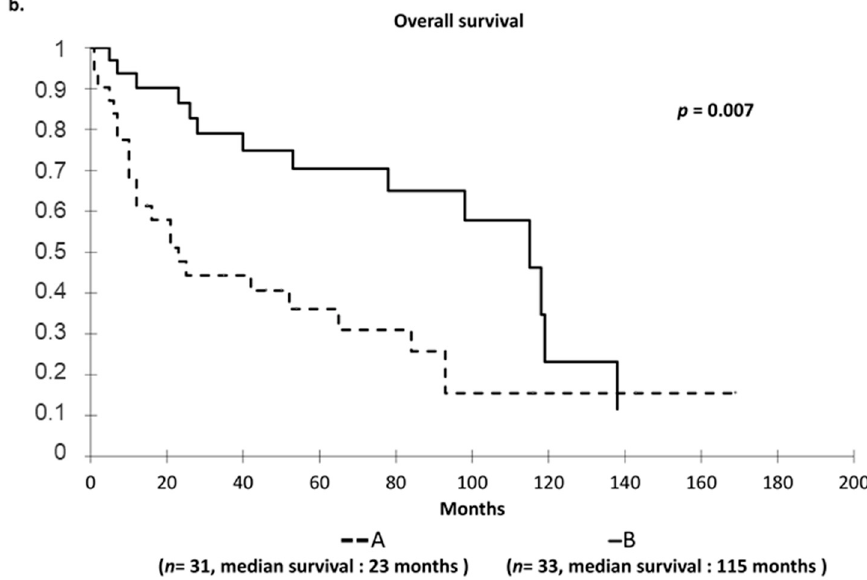
Figure 1. ( a ) Hierarchical clustering of brain tumors based on expression profiles of 26 genes in studied cohort: log2-transformed and mean-centered fold-change values from 26 genes fulfilling the criterion of statistically significant deregulation between two stages of glioma ( p < 0.05). Red and blue indicate transcript levels above and below median values, respectively. Tumor samples are identified by numbers, and genes by their symbols. Each column indicates the gene expression profile of a sample, and each line indicates variations in the expression level of a given gene among tumor samples. The length of branches on trees forming dendrograms on top of each panel reflects the degree of similarity between samples. Subdivision of samples into two groups according to the dendrogram was subsequently used for survival analysis. ( b ) Overall survival in the studied cohort by Kaplan–Meier analysis: Survival group A (dotted line) defined unfavorable prognosis, and survival group B (solid line) defined favorable prognosis ( p = 0.007). P-values were calculated using log-rank test. Group A was defined by high expression of EGF , NGF , FLT4 , KDR , AREG , NTRK1 , VEFGA and CHI3L1 and low expression of SYP , INA , ST3GAL5 , OLIG2 , KLRC3 , NTSR2 , PINK1 , NRG3 , ERBB4 , NTRK2-FL , NTRK2-T1 , AKT3 , PARK2 , NANOG , NTRK3 , NRG2 , BRAF and NRG4 , whereas